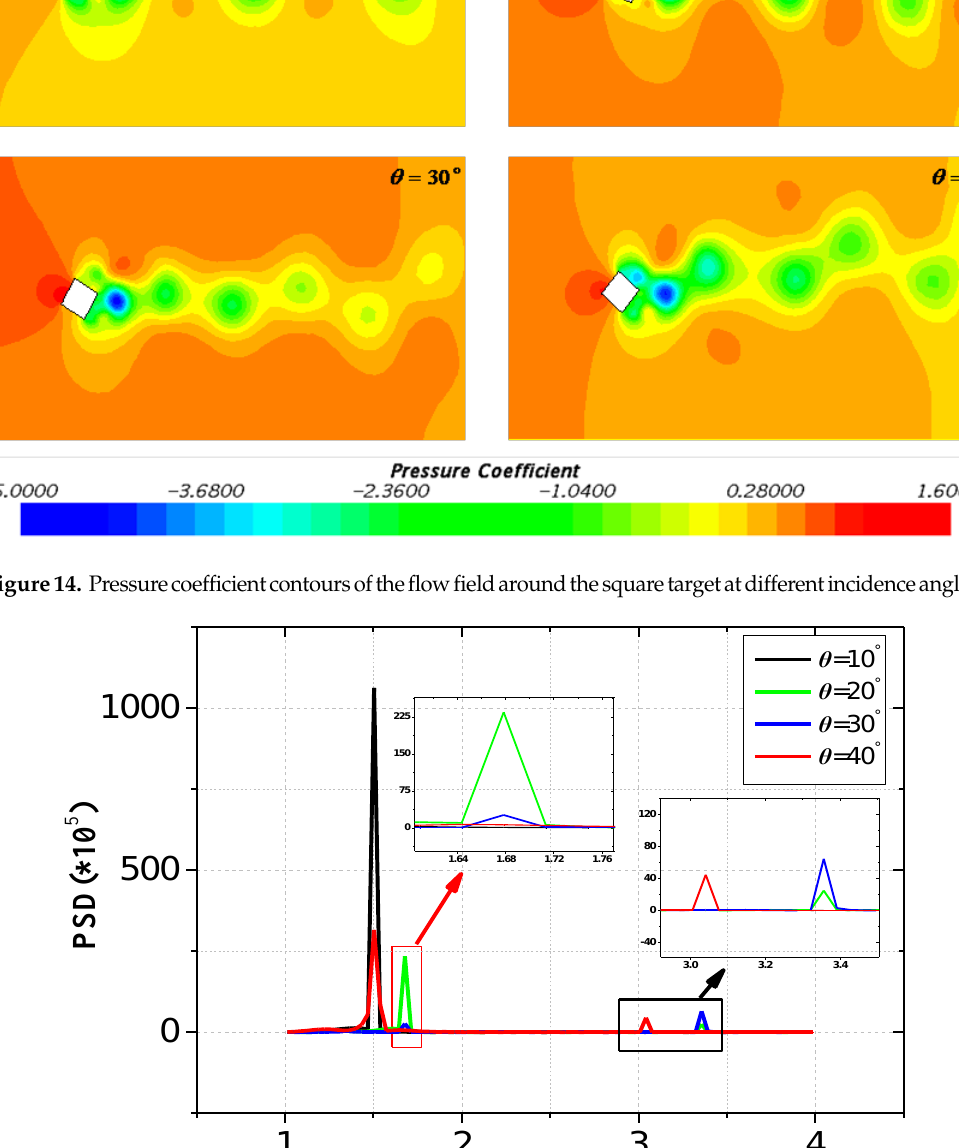
Figure 15. Effects of incidence angles of the square target on the power spectrum density.